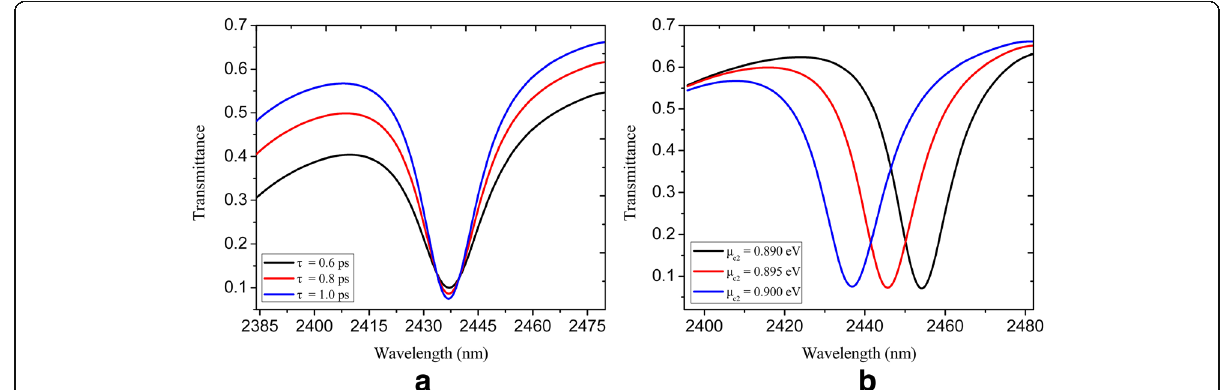
Fig. 2 Spectral transmittance of a U-shaped nanocavity-coupled waveguide system shown in Fig. 1: a with τ = 0.6, 0.8, and 1 ps; μ c1 = 0.3 eV; and μ μ c2 = 0.9 eV; b with c2 = 0.89, 0.895, and 0.9 eV;